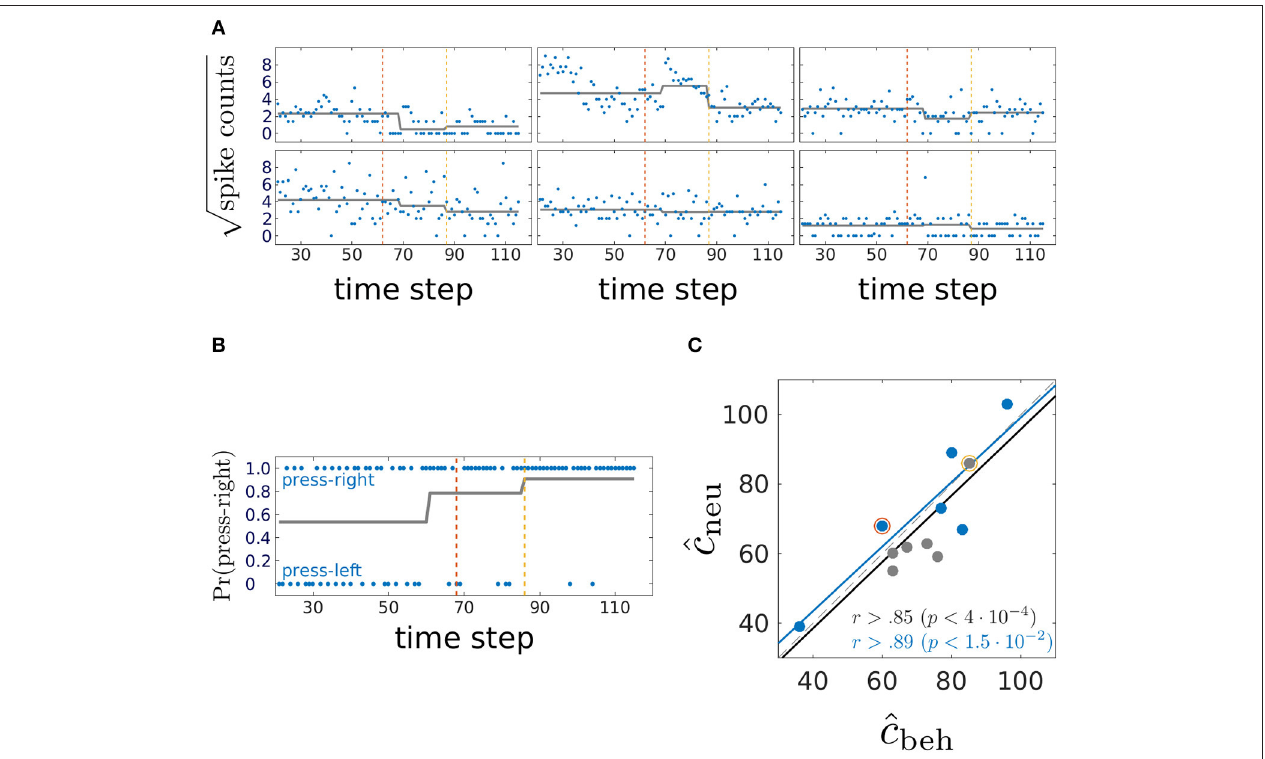
FIGURE 9 | Comparing behavioral and mPFC neural CPs; (A) blue, square-root-transformed spike count data in the three seconds following cue onset from 6 representative mPFC units of one rat; gray, mean as estimated by inverting the neural multiple response PARCS 2 model. Note potential CP in top-center unit which was not detected by PARCS 2 since it did not contribute strongly to population-wide CPs; dashed lines, behavioral CPs from the same animal; (B) blue, lever press at each trial; this animal is rewarded for pressing the right lever during the spatial rule; gray, probability of pressing right lever as estimated by inverting the behavioral PARCS 2 model; dashed lines, neural CPs from the same animal (see A ); (C) relating behavioral and neural CPs; blue, behavioral CPs with higher weight; r , correlation coefficients as computed over all 12 data points (black) and over those where behavioral CPs have the higher weight (blue); p -values, significance levels of corresponding r ; black and blue lines, respective least-square linear regression fits to the two sets of data points; red and yellow circles, neural and behavioral CP pairs from the exemplary animal in (A,B) ,